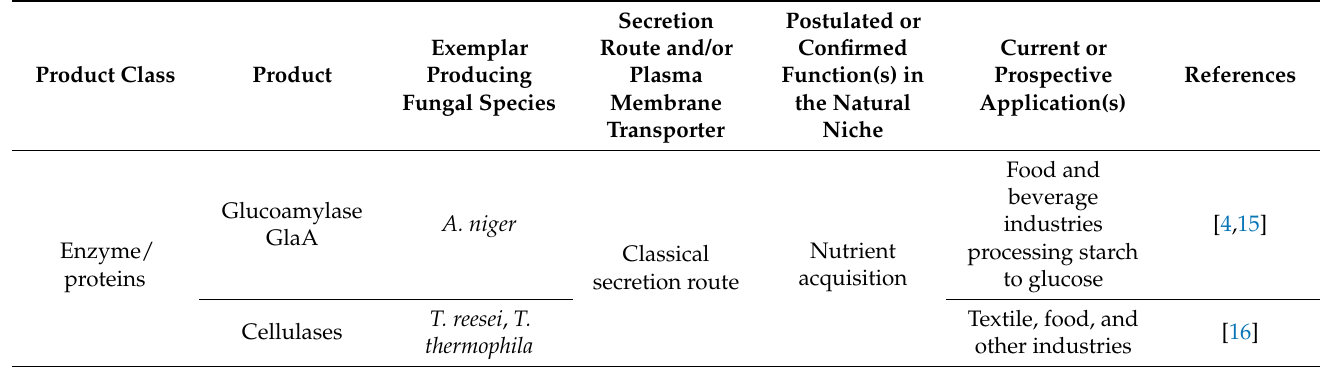
Figure 2. Interconnections between organic acid, protein, and secondary metabolite biosynthesis in filamentous fungi. Schematic diagram is a simplified model of filamentous fungal carbon catabolism when utilizing sugars. The main classes of molecule are depicted in grey boxes, with some exemplar secreted molecules discussed in this review highlighted in parentheses. Acetyl-CoA is a crucial link between both primary and secondary metabolism. Note ATP and NAD(P)H are not indicated in the schematic for simplicity. Modified from [14]. Table 1. Summary information of filamentous fungal secretion and exemplar applications of their extracellular molecules. Species listed are meant as examples only and are not exhaustive. The most common postulated and/or confirmed functions of these molecules are given, but in several instances their precise role is still unclear (e.g., citric